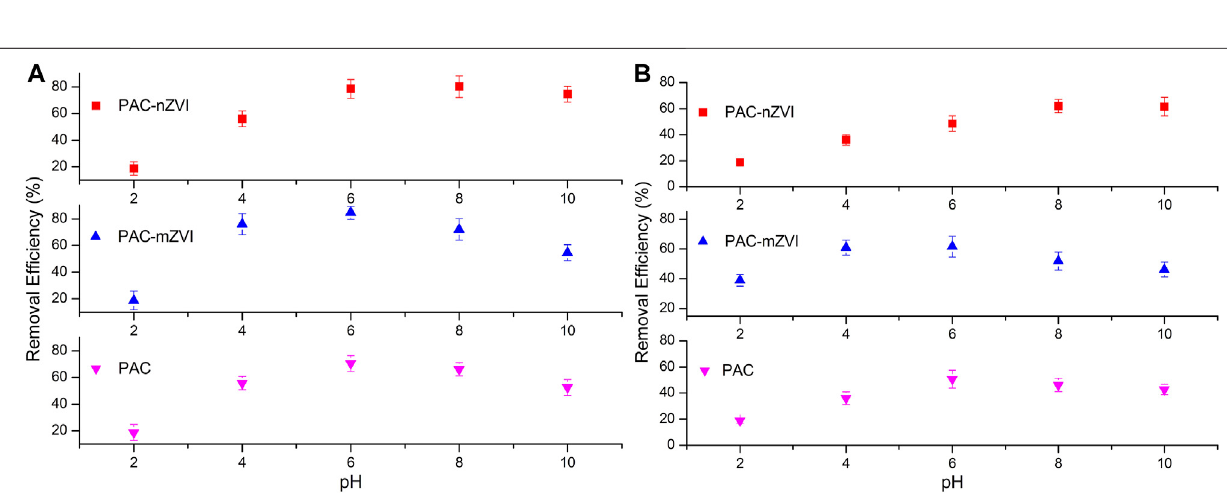
Frontiers in Environmental Science |